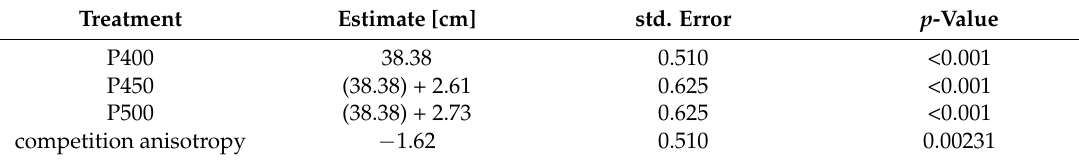
Table 1. Effects on breast height diameters (dbh) of plantation density and of lateral compression, measured in terrestrial laser scanning (TLS) point clouds. As distance to nearest competitor decreases dbh increases. Diameters facing the nearest competitor are smaller than the orthogonal ones. Standard errors and p -values have been assessed by a 2-way ANOVA considering TLS-dbh treatments and diameter directions as independent